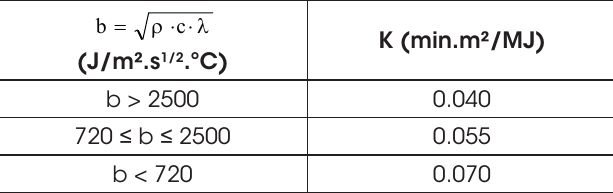
Values of K in function of the compartmentation